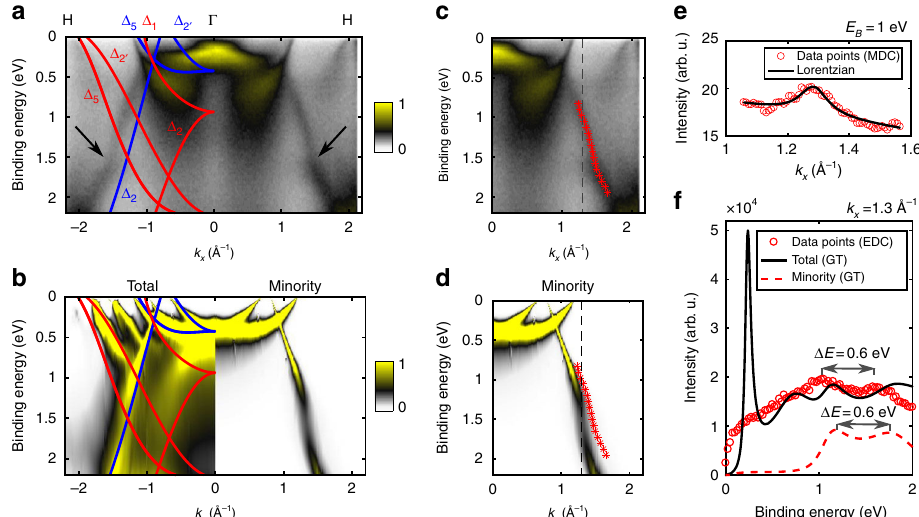
Fig. 2 Kink far below the Fermi level observed by the photoemission experiment and reproduced by the GT theory. a Photoemission measurement performed using h ν = 70 eV and s-polarized light. Superimposed is the result of the single-particle LSDA calculation, where blue and red lines indicate minority and majority bands, respectively. Arrows show the region of the dispersion anomaly. b Result of the renormalization with the GT self-energy for both spin directions ( k x < 0) together with the undressed LSDA bands and only for the minority spin ( k x > 0). Experimental ( c ) and theoretical ( d ) results with superimposed peak positions extracted from the Lorentzian fi ts (red symbols). e Exemplary MDC for E b = 1.0 eV (circles) with a Lorentzian fi t (solid line). f Total and minority theoretical (black solid and red dashed lines) and total experimental spectral function (red symbols) obtained for k x = 1.3 Å − 1 , marked by dashed vertical lines in c and d